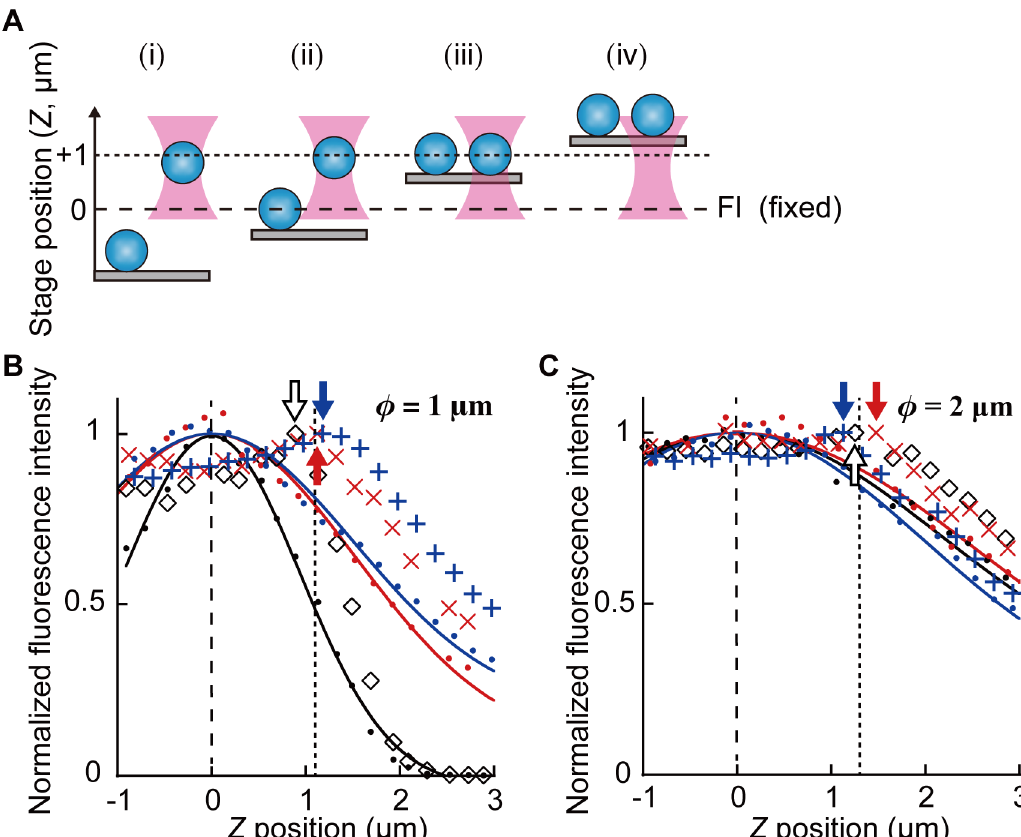
Fig 3. The procedure to determine the height of the trap center from the focal plane of the fluorescence microscopy. (A) Schematics showing the procedure to measure the trap height. Objective lens is fixed in space. (i) The focal plane of the bright- field microscopy (dotted line, adjustable by the position of the camera) is preset at about 1 μ m above that of the fluorescence microscopy (dashed line). A floating bead is trapped. (ii) While the other bead is attached to the coverslip, the sample stage is elevated in steps (200 nm each). (iii) When the coverslip touches the trapped bead, the bead is adsorbed to the coverslip. (iv) Both beads are elevated together with the sample stage. (B and C) Data showing the changes in fluorescence intensity during the trap height measurement obtained with beads with the diameter of 1.0 μ m (B) or 2.0 μ m (C). Dots represent the change in the fluorescence intensity of the beads adsorbed to the coverslip when the sample stage was lifted upwards. The symbols (+, x, ^ ) indicate the fluorescence intensity of the trapped beads. Three individual trials are represented by three different colors. The fluorescence intensities were determined in square regions. The size for the beads with the diameter of 1.0 μ m was 2.2 μ m X 2.2 μ m for the data indicated in black or 1.8 μ m X 1.8 μ m for the data indicated in blue and red. For the beads with the diameter of 2.0 μ m, the size was 3.3 μ m X 3.4 μ m. The change of the fluorescence intensities along the Z axis can be fit to the Gaussian distribution (shown in thin curves with the same color as corresponding dots). The peak position of the Gaussian distribution is the focal plane of the fluorescence microscopy ( Z = 0, vertical dotted line). After the intensity peaks at about Z = 1 μm (arrows with the same color as corresponding symbols), it begins to decrease in the same way as those of the bead adsorbed to the coverslip. This is because the trapped bead is adsorbed to the coverslip and it moves together with the pre-adsorbed bead. From the peak positions (1.1 ± 0.15 μm and 1.3 ± 0.18 μm for beads with the diameter of 1.0 μm and 2.0 μm, respectively; mean ± SD, vertical dashed line), we estimated the distance of the trapped 1.0 μm beads from the focal plane as Z = 0.88 μm after the correction for aberration (see main text for